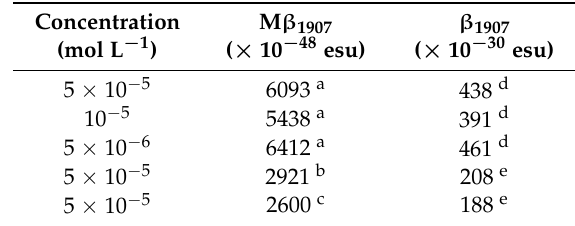
Table 4. EFISH μβ 1907 values as a function of the concentration and of the solvent for chromophore 1. Adapted from J. Phys. Chem. C 2009 , 113 , 11131–11141.